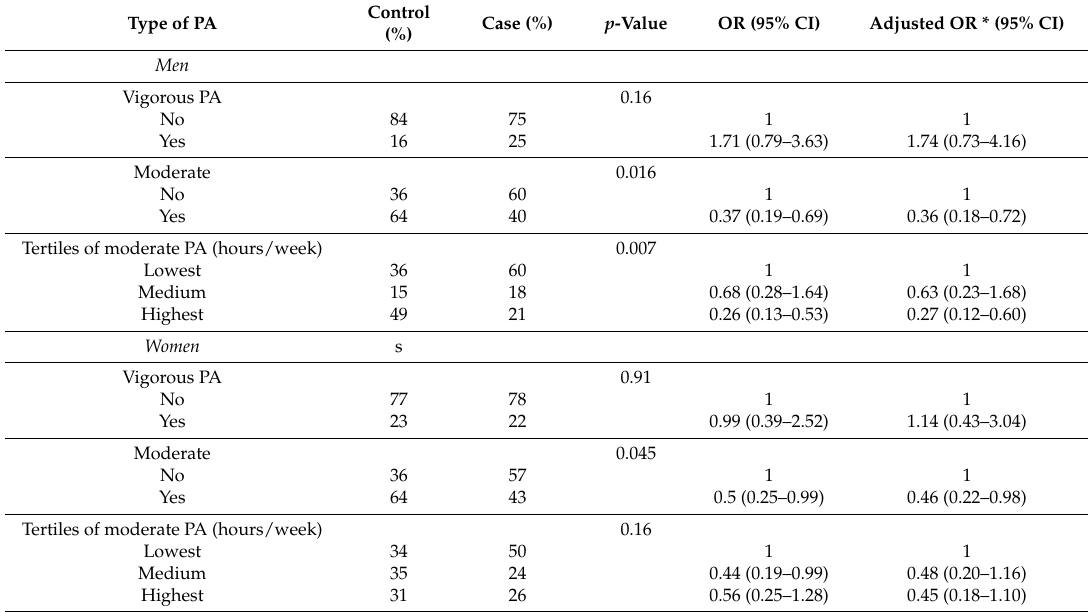
Table 4. Association between work-related PA and CHD by